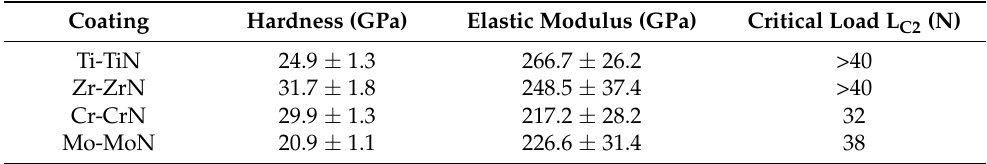
Table 3. Hardness, elastic modulus, and fracture force during the scratch testing of the Ti-TiN, Zr-ZrN, Cr-CrN and Mo-MoN